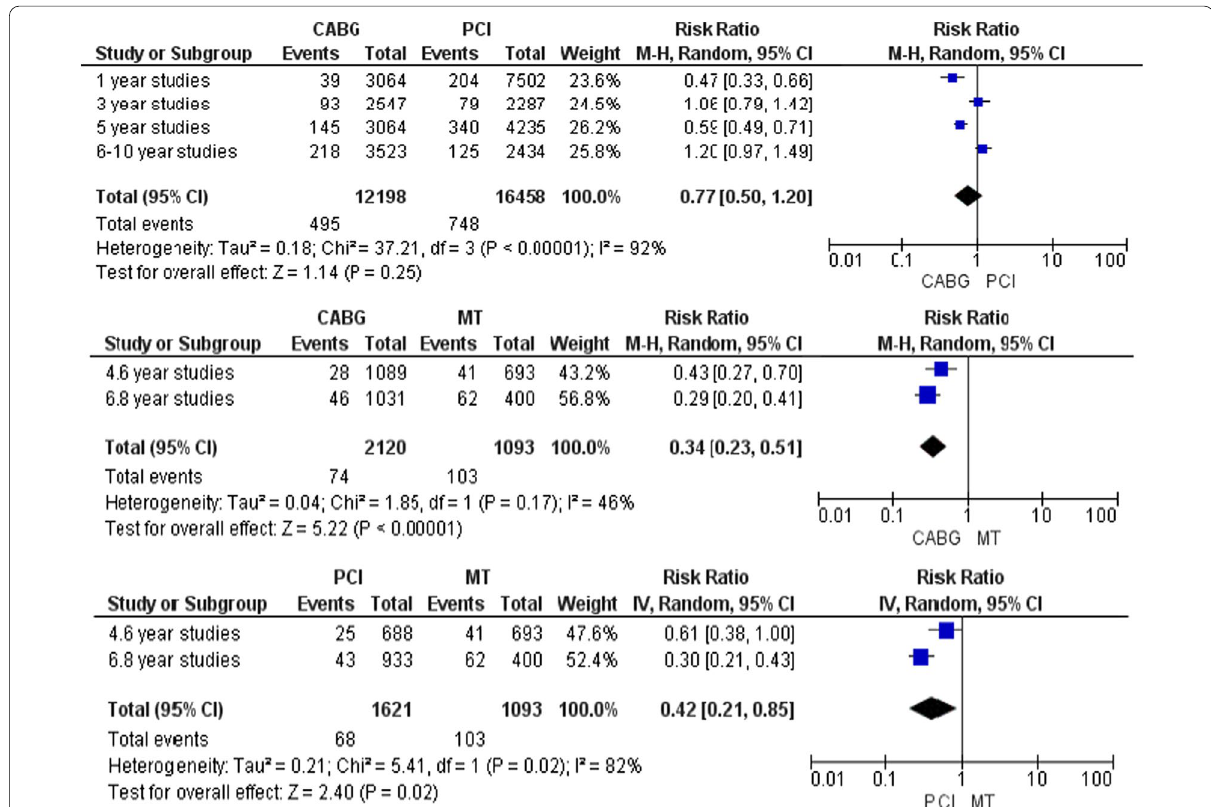
Fig. 5 Comparisons of procedures in CAD patients under 60 years old without adjustment of baseline characteristics